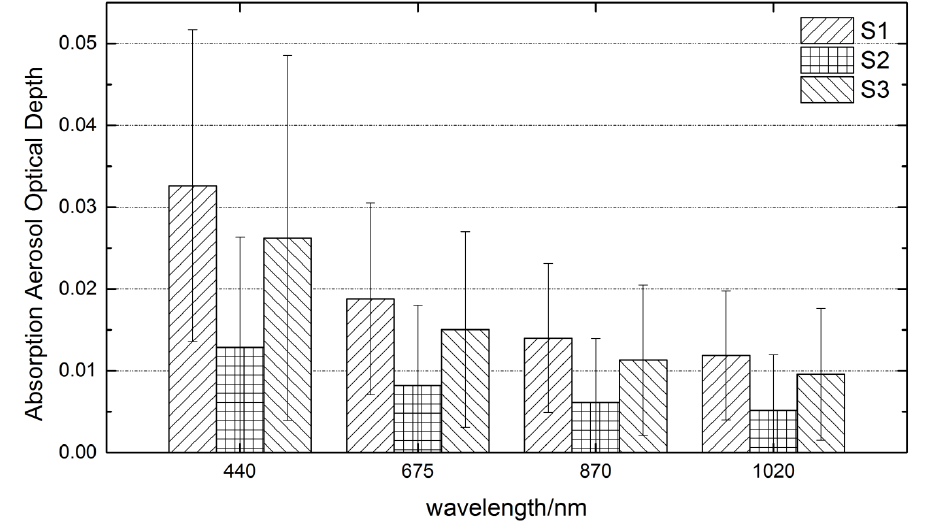
Figure 6. Variation in mean AAOD at different wavelengths.